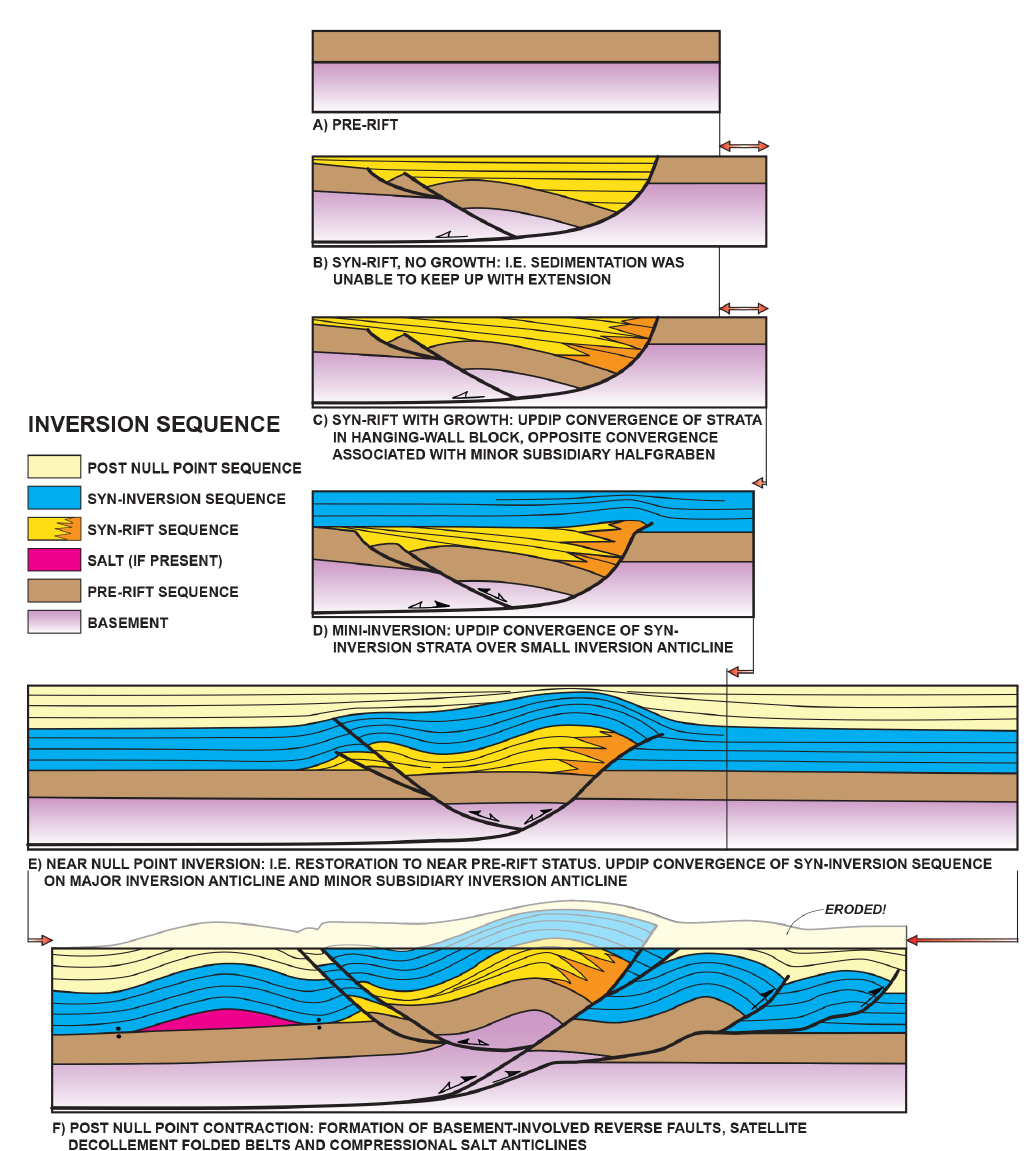
Figure 1. Extended version of Bally’s (1984) original inversion model. This cartoon was redrafted after an unpublished figure made by Albert W. Bally in the early 2000s at Rice University to show the progression of inversion tectonics into the formation of an incipient folded belt. Specifically, he made this cartoon with the western High Atlas of Morocco in mind (e.g., Hafid et al., 2006); that is why salt is shown here as a detachment level accommodating some of the